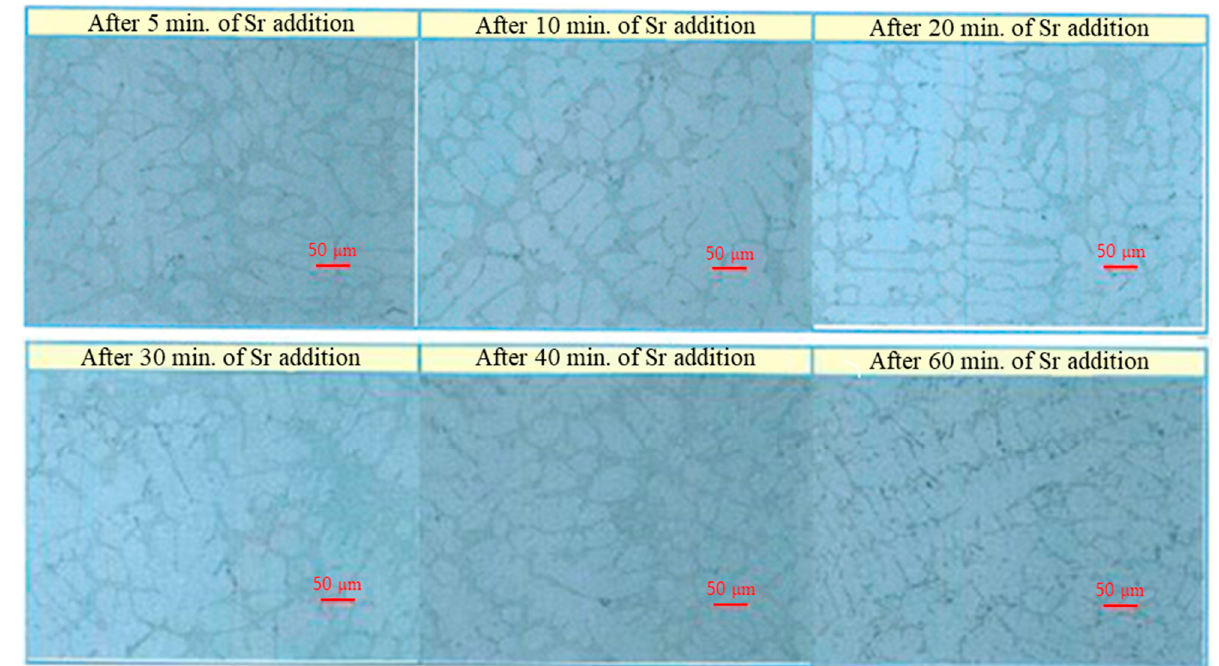
Figure 7. Changes in Si structure with casting time.